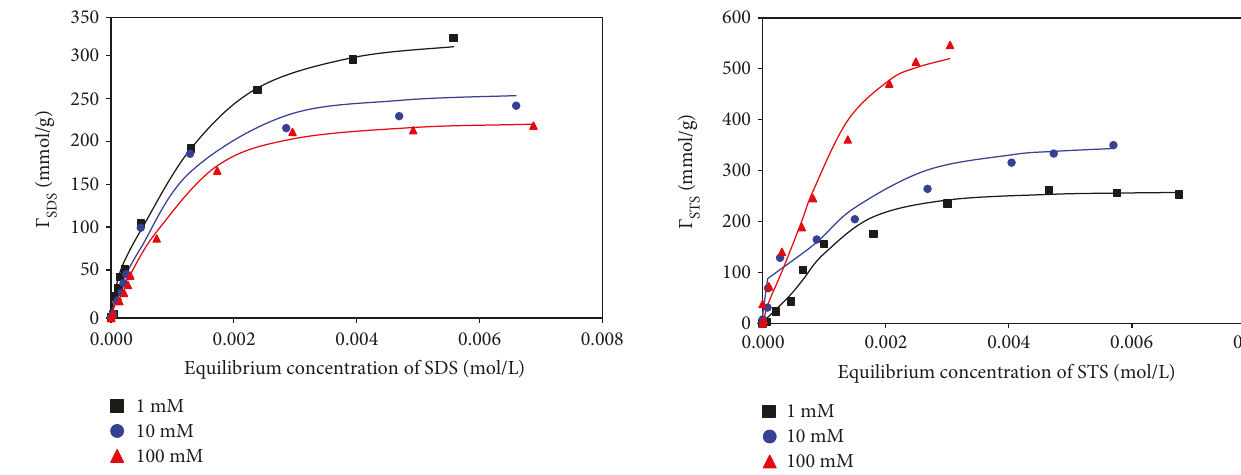
O in di ff erent 2 3